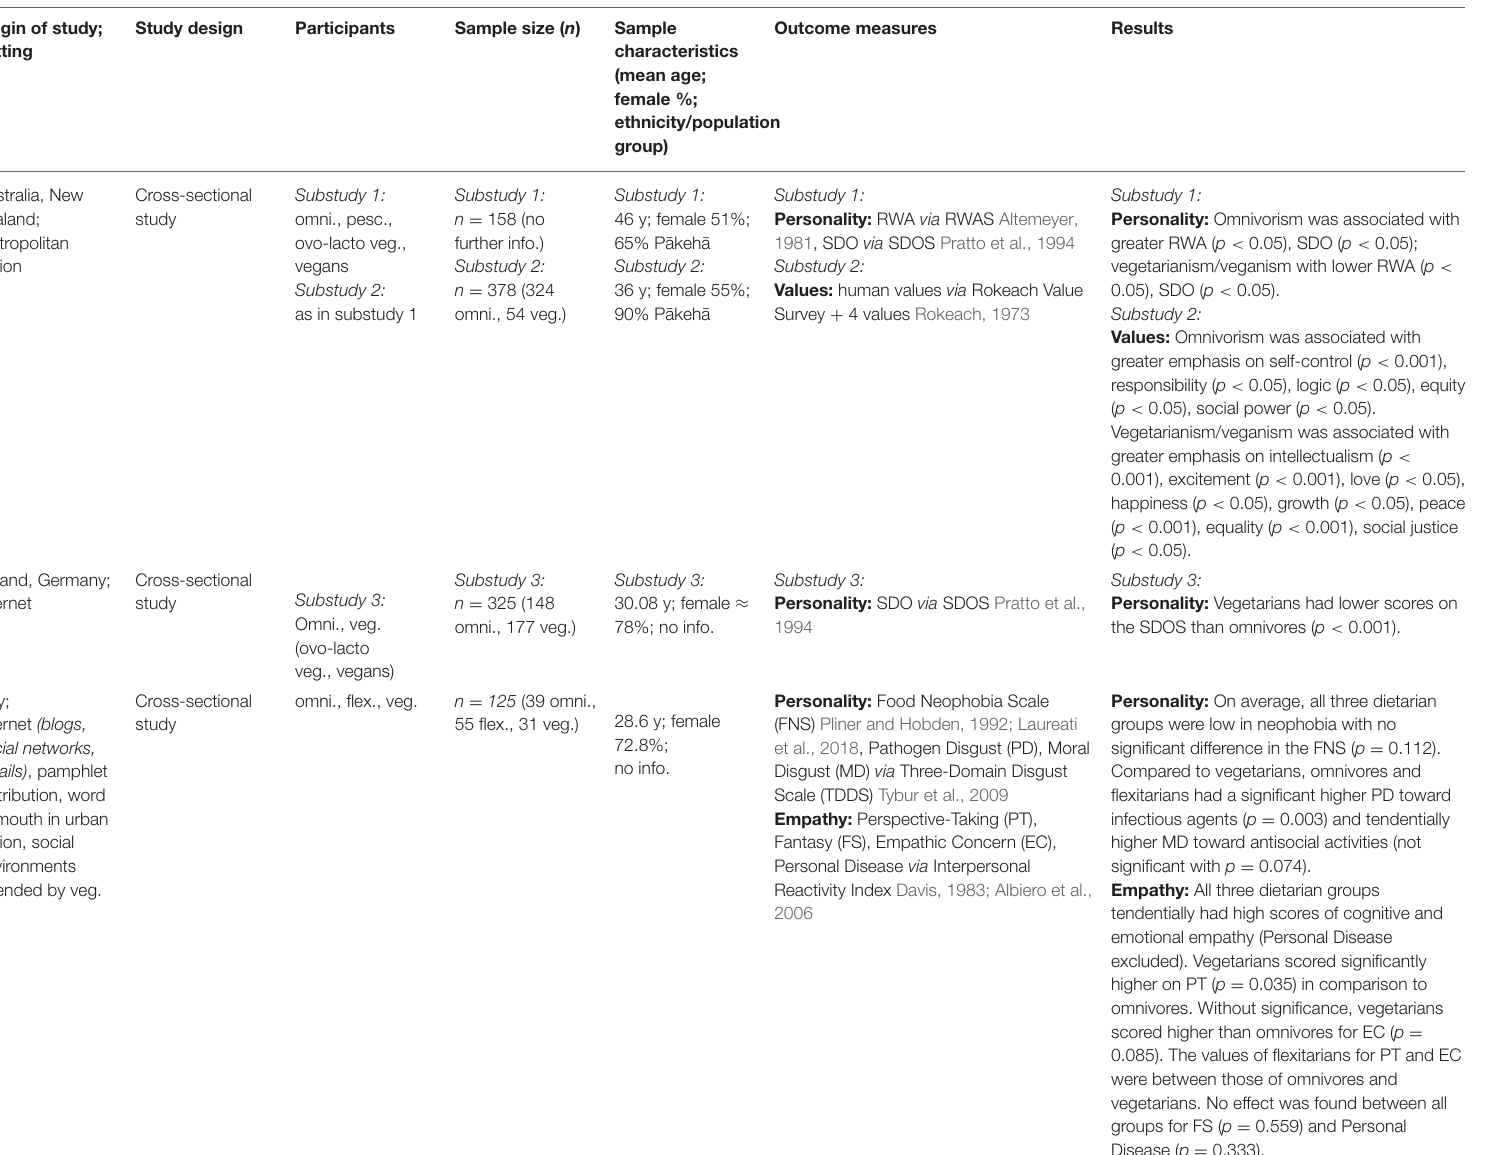
TABLE 1 | Characteristics of the included